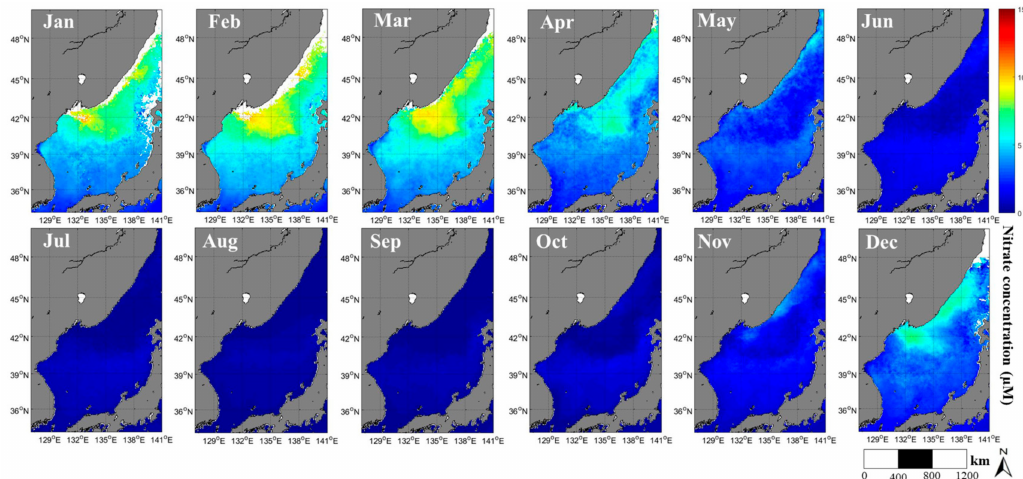
Figure 4. Climatological monthly images of Sea Surface Nitrate (SSN) in the East/Japan Sea (EJS).